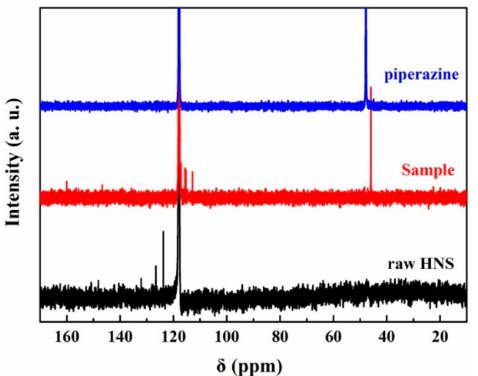
Figure 5. The 13 C NMR of raw HNS (black), piperazine (blue) and the sample: nanoenergetic derivatives (red), using acetonitrile-d 2 as a deuterium